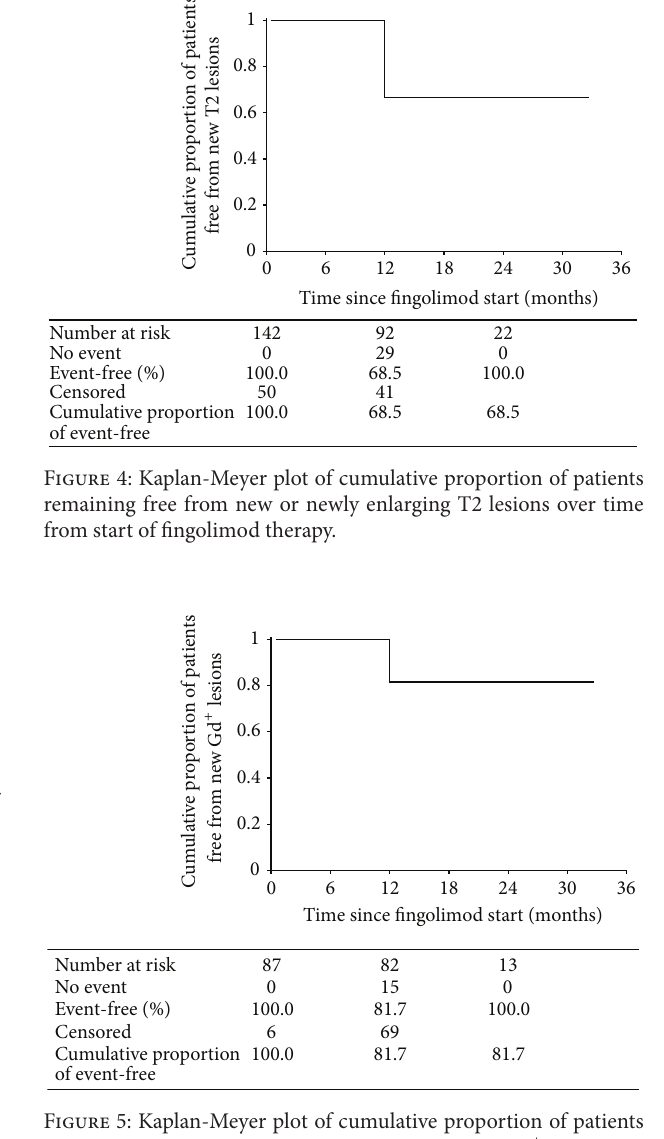
patients undergoing previous natalizumab treatment (26.7% versus 15.3%, 𝑝 = 0.046